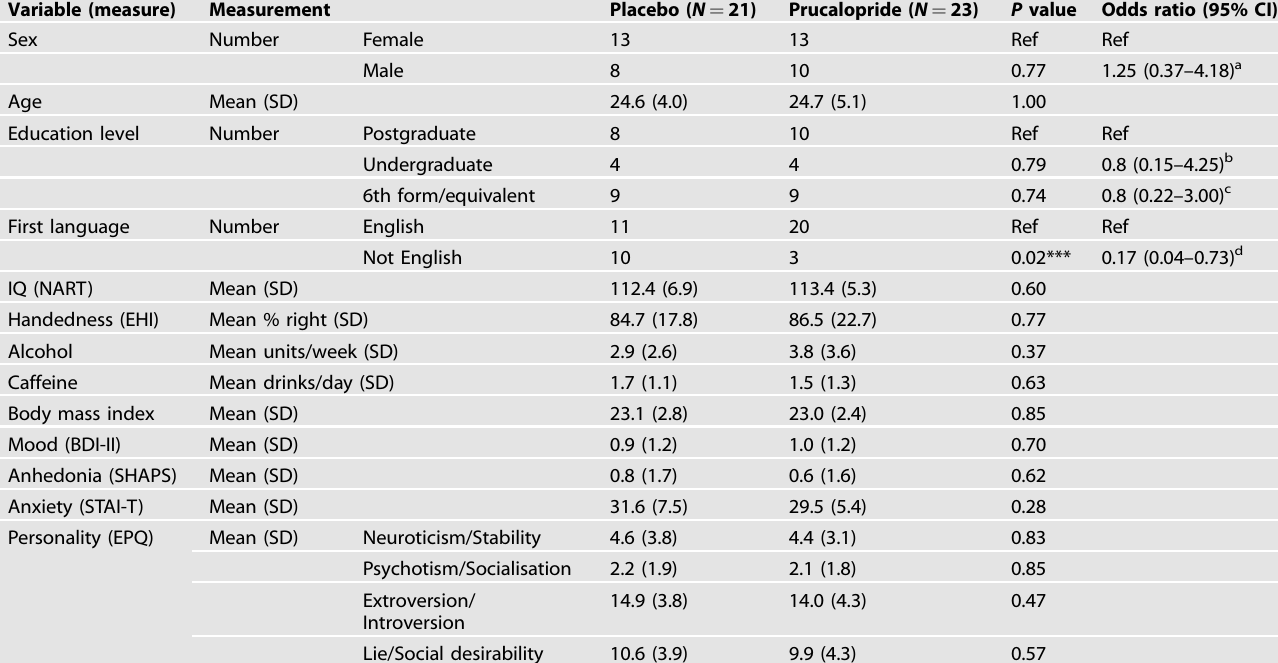
Table 1. Sample demographics, baseline mood &